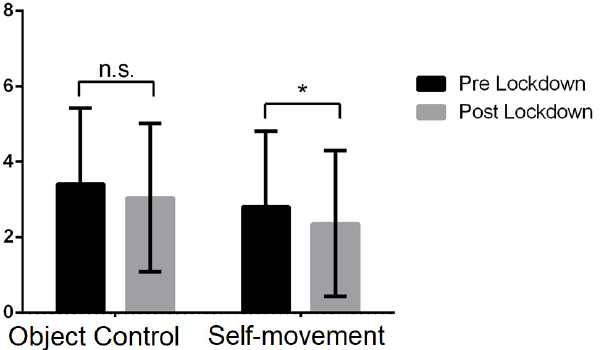
Figure 1. Comparison of AMC (object control and self-movement) pre- and post-lockdown. n.s. means no significant differences, whereas * means significant differences ( p < 0.05).